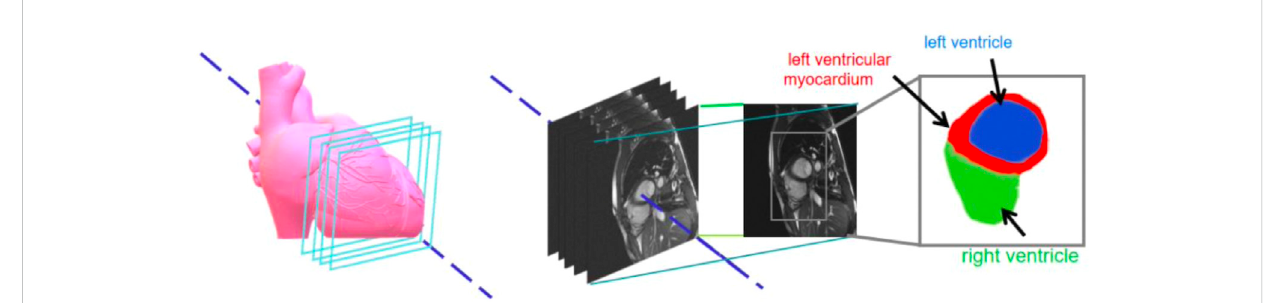
FIGURE 2 Sample datasets pertaining to cardiac images and magnetic resonance images with respective enlargements.